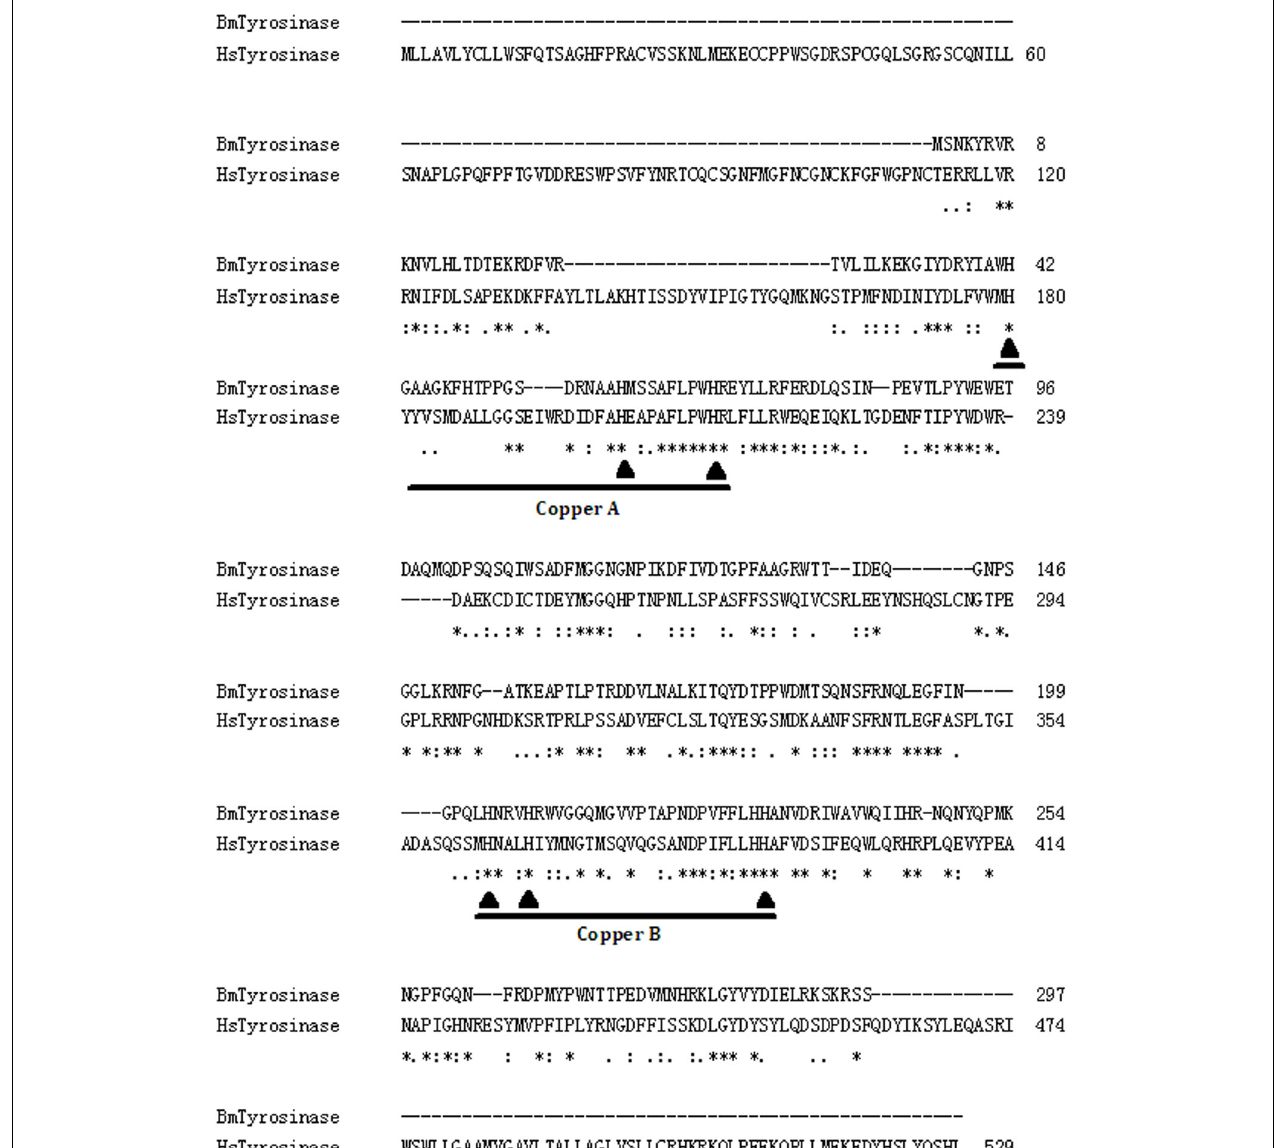
FIGURE 4 | Comparison of the amino acid sequences of Homo sapiens tyrosinase (HsTyrosinase; Accession number: AAB60319) and Bacillus megaterim tyrosinase (BmTyrosinase; Accession number: ACC86108). The online CLUSTALW multiple sequence alignment software ( http://www . genome . jp/tools/clustalw/ ) was used for the slow and accurate pairwise